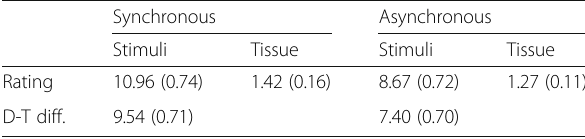
Synchronous Asynchronous